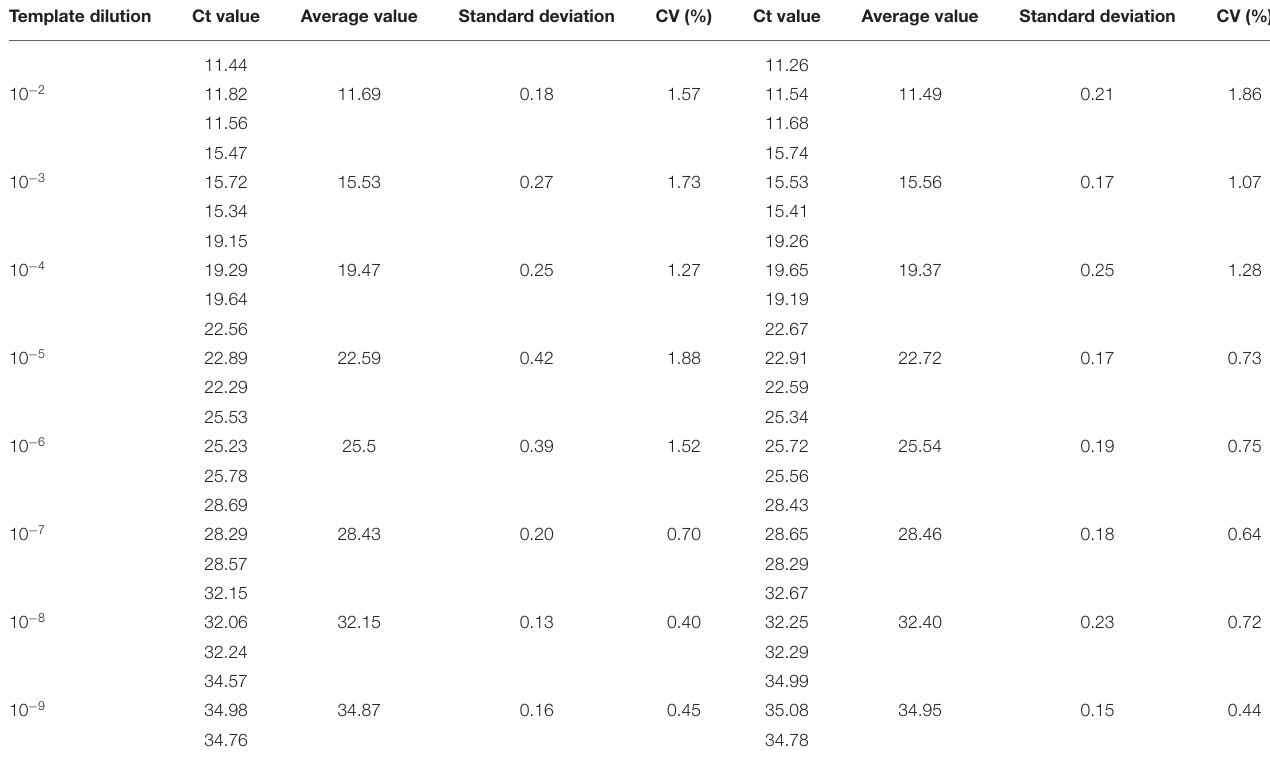
TABLE 3 | Intra-reproducibility and intra-repeatability of B646L gene by dual real-time PCR. Template dilution